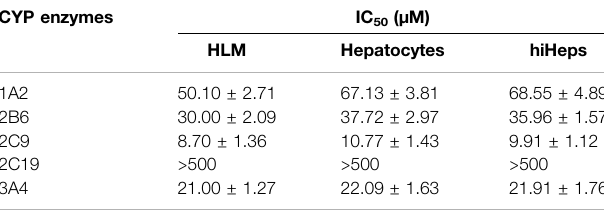
TABLE 1 | The IC 50 values of curcumin to fi ve CYP enzymes ( n (cid:2) 3). CYP